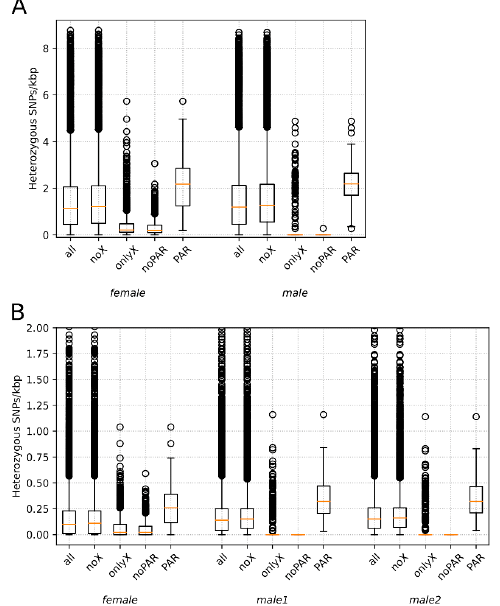
Figure 5. SNP density (SNPs per kbp) in 100 kbp windows inside and outside pseudoautosomal